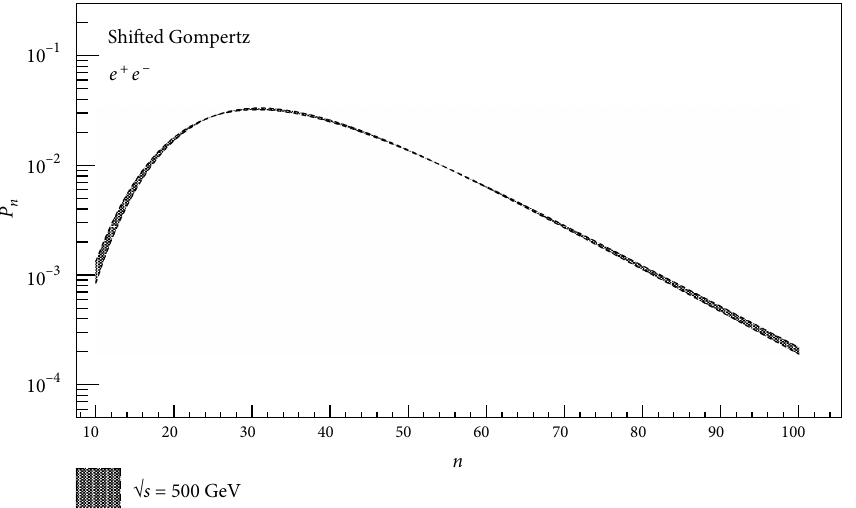
+ − collisions at 𝑒 𝑒